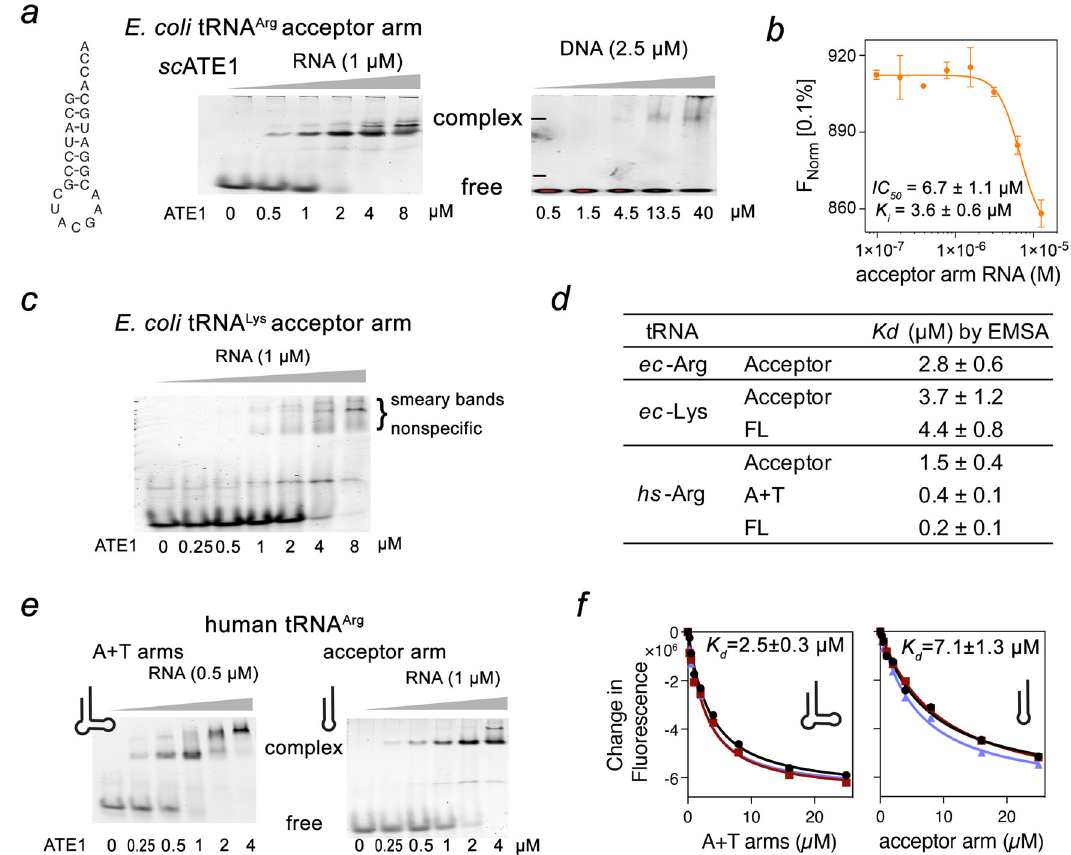
Fig. 5 | Acceptor arm recognition and the proposed mechanism of ATE1- mediated arginylation. a Sc ATE1 recognizes the acceptor arm of tRNA. Repre- sentativeEMSAassayofATE1bindingtosynthesizedRNA(middle)andDNA(right) with sequence shown on the left. ATE1 concentrations are shown below the gel. Three independent experiments were performed with similar results. b Binding curves used to determine the K i value of ATE1-RNA interaction in a competition assay by MST. Error bar represents s.d. in duplicate measurements. c Representative EMSAassayof ATE1binding to synthesizedtRNA Lys acceptor arm. Threeindependentexperimentswereperformedwithsimilarresults. d K d valuesof